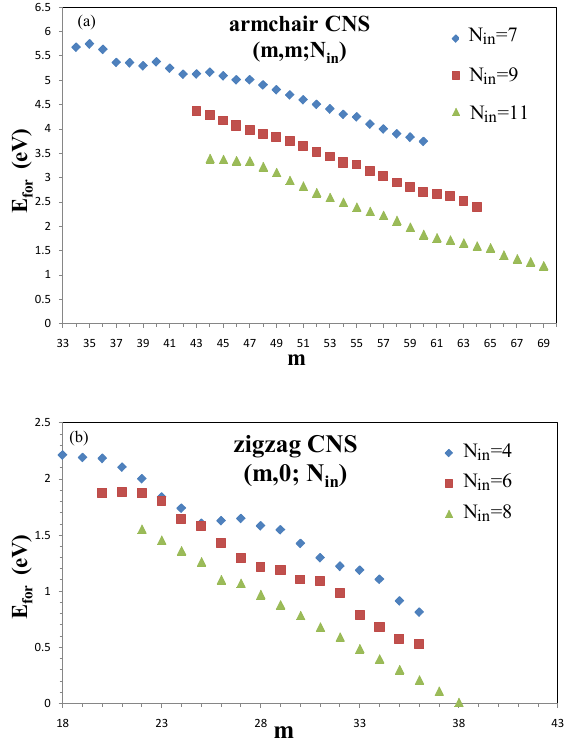
Figure 3. Formation energy of the scroll widths for ( a ) armchair CNS and ( b ) zigzag CNS with different internal